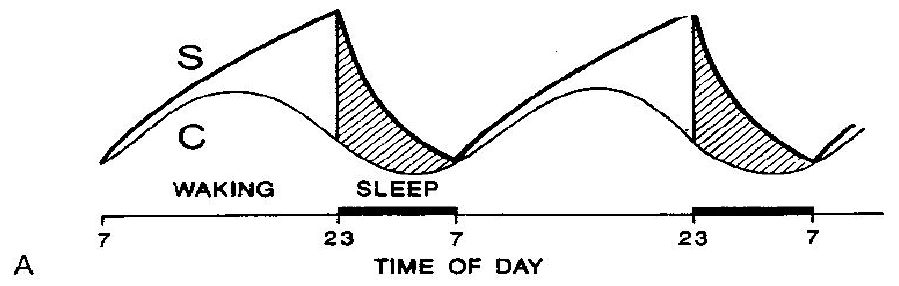
Figure 1. Circadian rhythm [32].